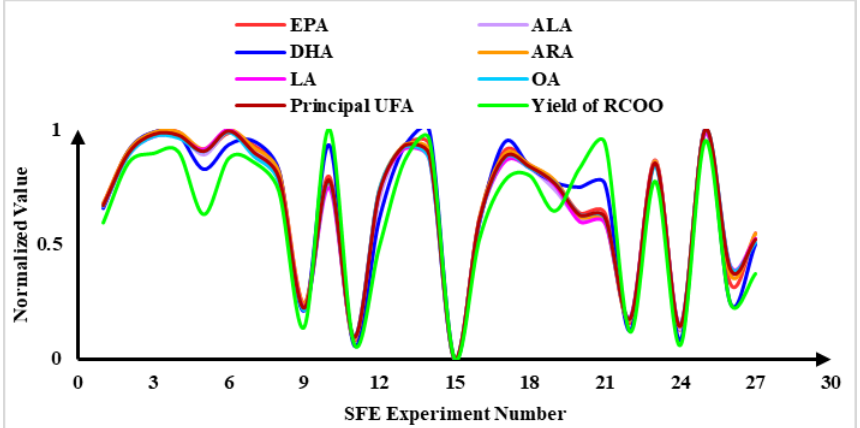
Figure 4. The change trend of the yield of principal unsaturated fatty acids (UFAs) and oil of Rana chensinensis ovum (RCOO) among different supercritical fluid extraction (CO 2 -SFE) experimental